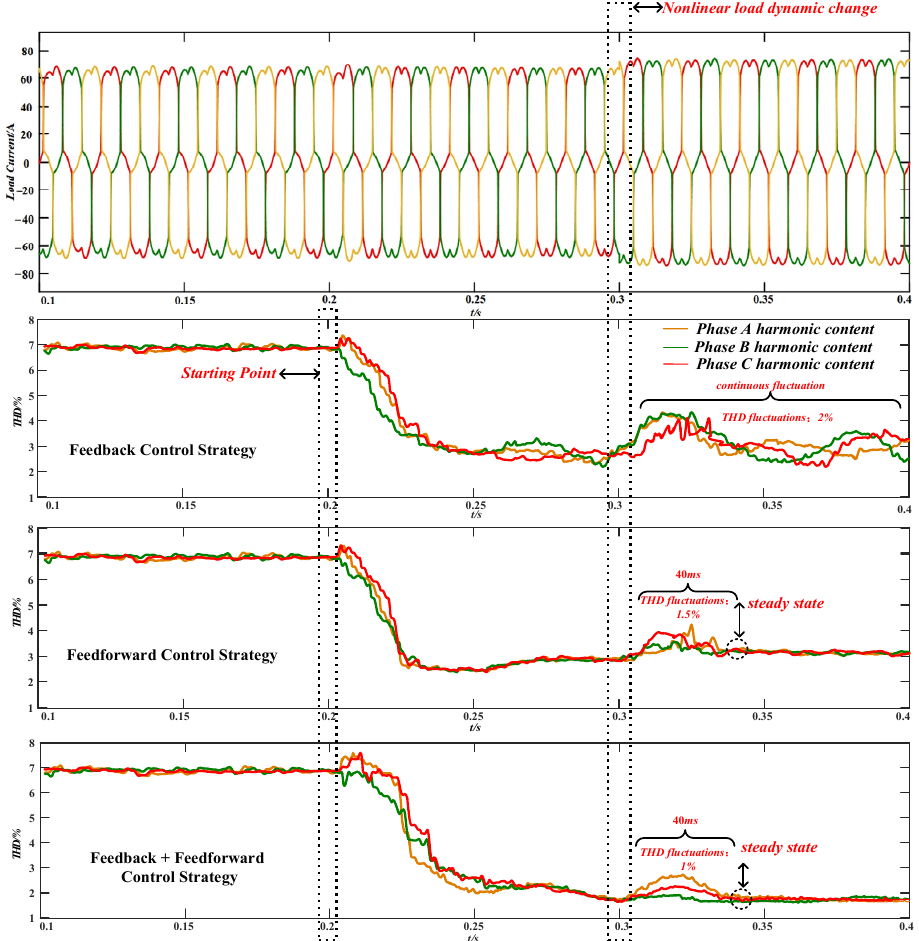
Figure 12. Harmonic suppression effects of different control algorithms under nonlinear load dynamic changes.